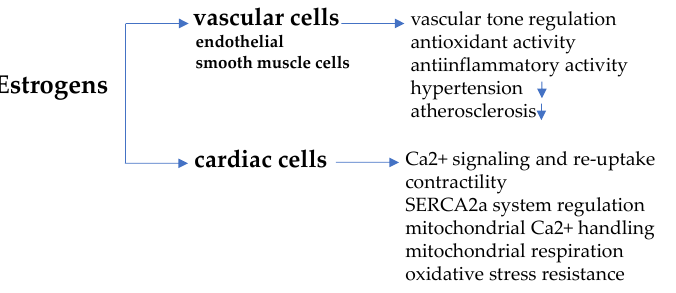
Figure 1. Estrogen-induced regulation in vascular and cardiac cells. Estrogens work against hyper- tension and atherosclerosis through anti-oxidant/anti-inflammatory activity and regulate vascular tone, acting on endothelial and smooth muscle cells. In cardiomyocytes, estrogens regulate cell con- tractility affecting Ca 2 + dependent signaling, mitochondria function and sarcoplasmic/endoplasmic reticulum Ca2 + -ATPase 2a (SERCA2a) system.